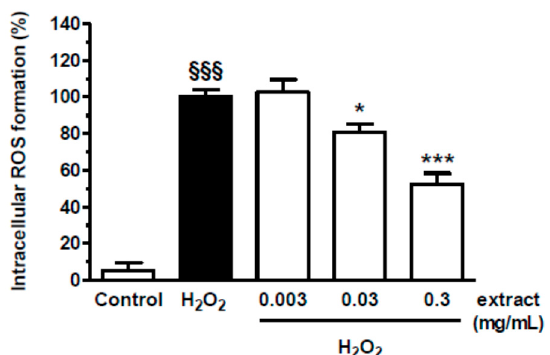
Figure 6. Antioxidant activity of spent coffee extract against the ROS formation induced by H 2 O 2 in HaCaT cells. Cells were treated with various concentrations of spent coffee extract (0.003–0.3 mg/mL) for 2 h and then treated with H 2 O 2 (100 µM) for 30 min. At the end of treatment, intracellular ROS formation was evaluated using the fluorescent probe H 2 DCF-DA, as described in the method section. Data are expressed as increased percentage of ROS formation versus untreated cells and reported as mean ± SEM of three independent experiments ( §§§ p < 0.001 vs. cells untreated; * p < 0.05, and *** p < 0.001 vs. cells treated with H 2 O 2 ; one-way ANOVA with Dunnett or Bonferroni post hoc test).